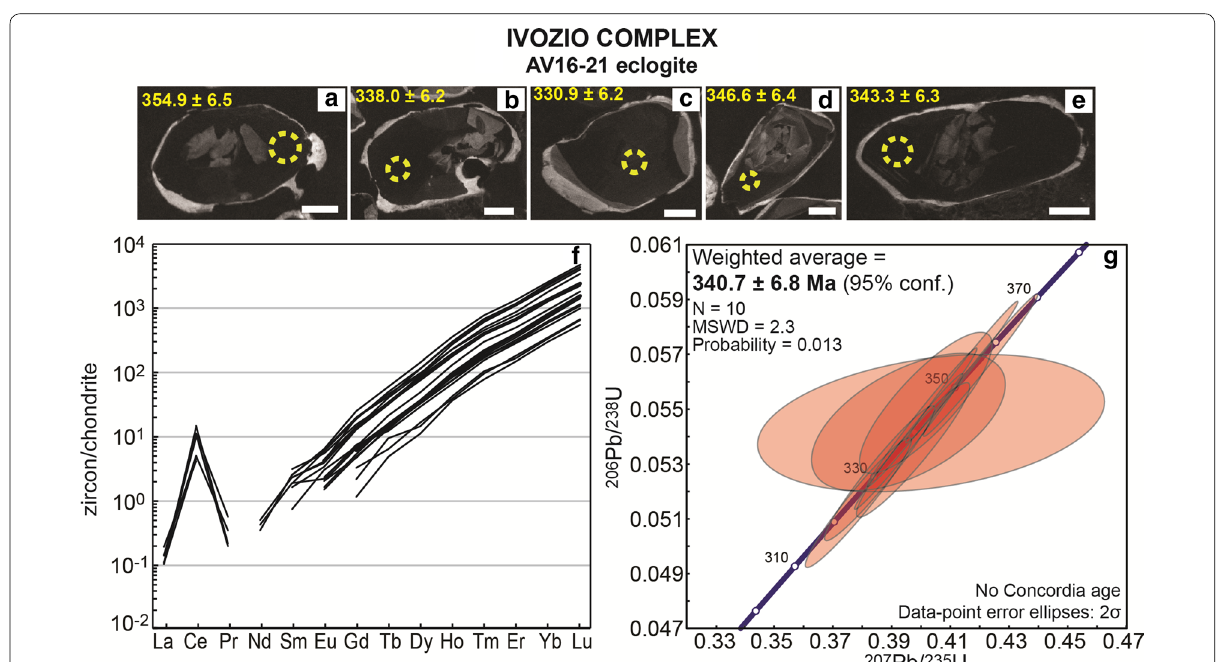
Fig. 7 Eclogite AV16-21, Ivozio Complex. a – e Selected CC images of analysed zircon grains. Scale bar in all images is 30 μm. Measured spots are shown (yellow circles) with the associated date ( 1σ Ma). f REE patterns of zircon cores. g Concordia plot of zircon core dates and weighted ± average 206 Pb/ 238 U